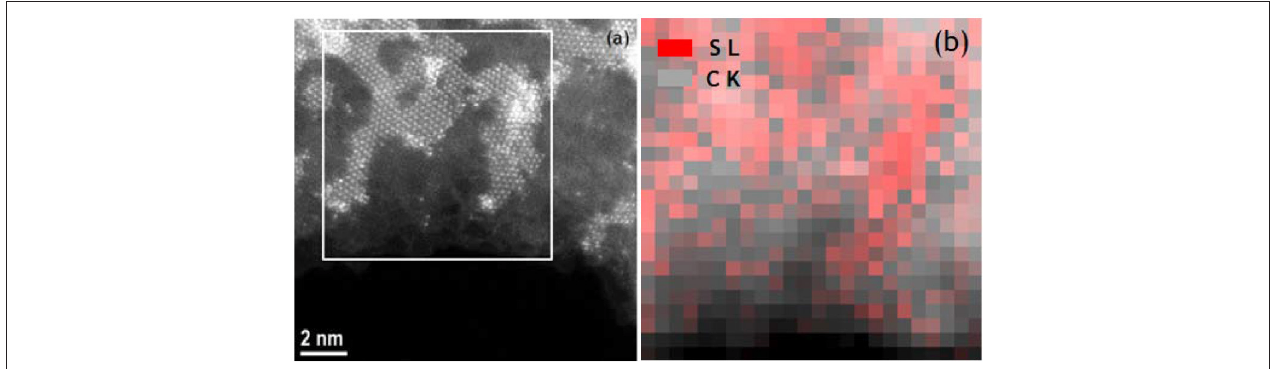
FIGURE 2 | Z-contrast STEM image (a) and EELS sulfur and carbon mapping (b) of MoS 2 -decorated few layer r-GO. (b) corresponds to the white box area of (a) .